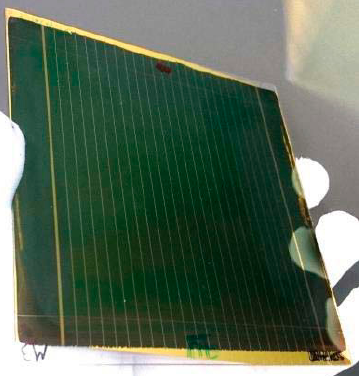
Figure 4. Picture of a 144 cm 2 S2S perovskite module. Copyright Reproduced with permission from Reference [4].